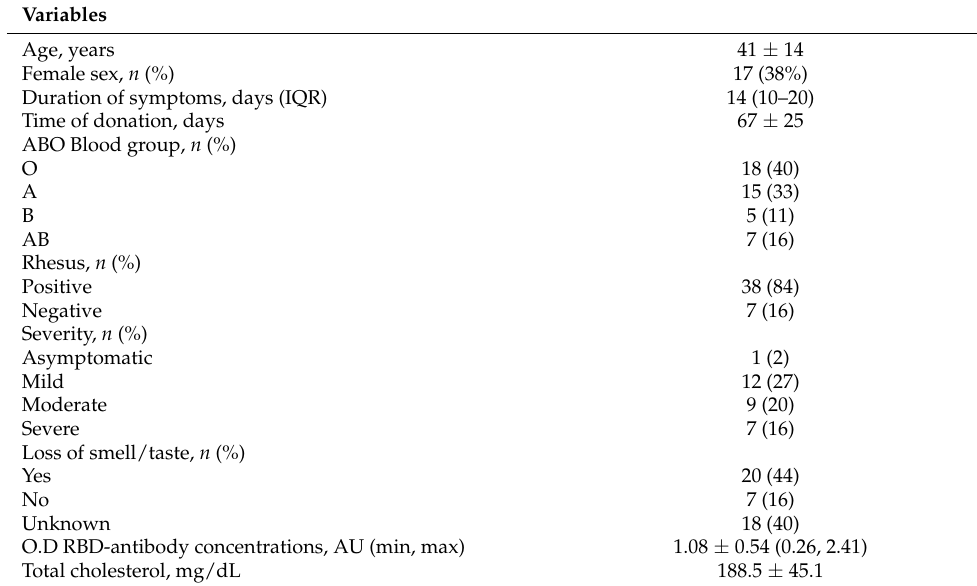
Table 1. Clinical parameters of donors of convalescent